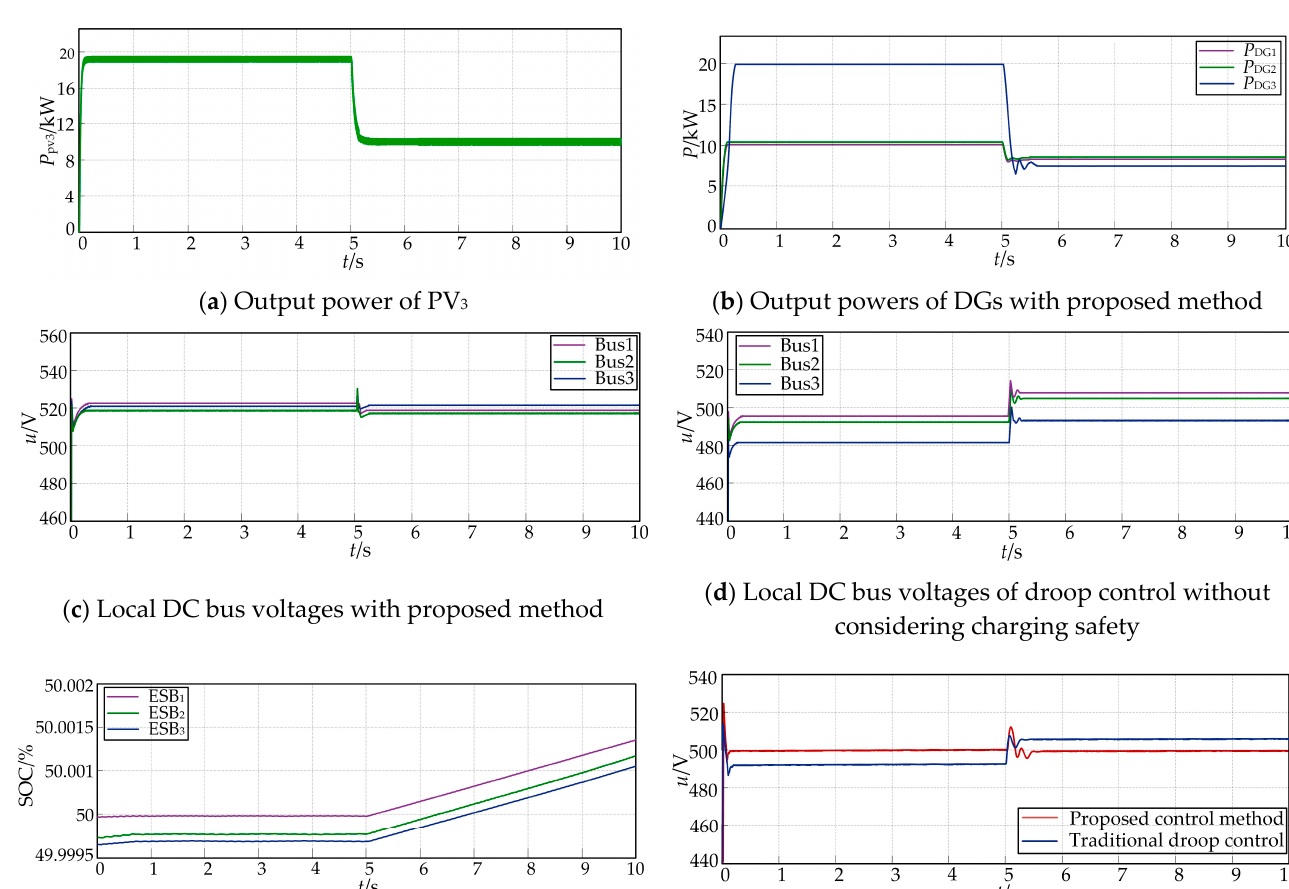
Figure 18. Simulation results of example 2 under the proposed control strategy in [8].